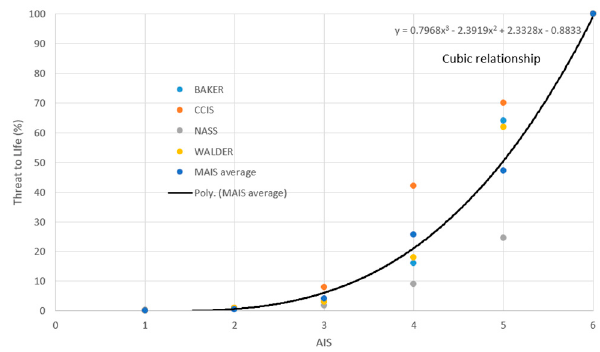
Figure 5. Relationship between Threat to Life (%) and AIS (Baker [38], CCIS [39], NASS [40], and Walder [41]).